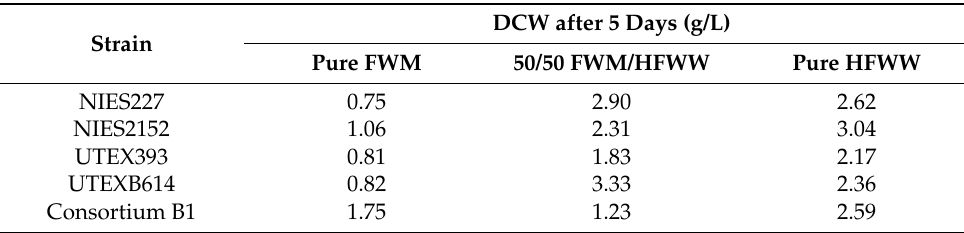
Table 2. Dry cell weight (DCW) (g/L) after 5 days of culture of the four strains and the consortium B1 in three different conditions: pure Fresh-Water Medium (FWM), a mix of 50/50 FWM and HFWW, and pure